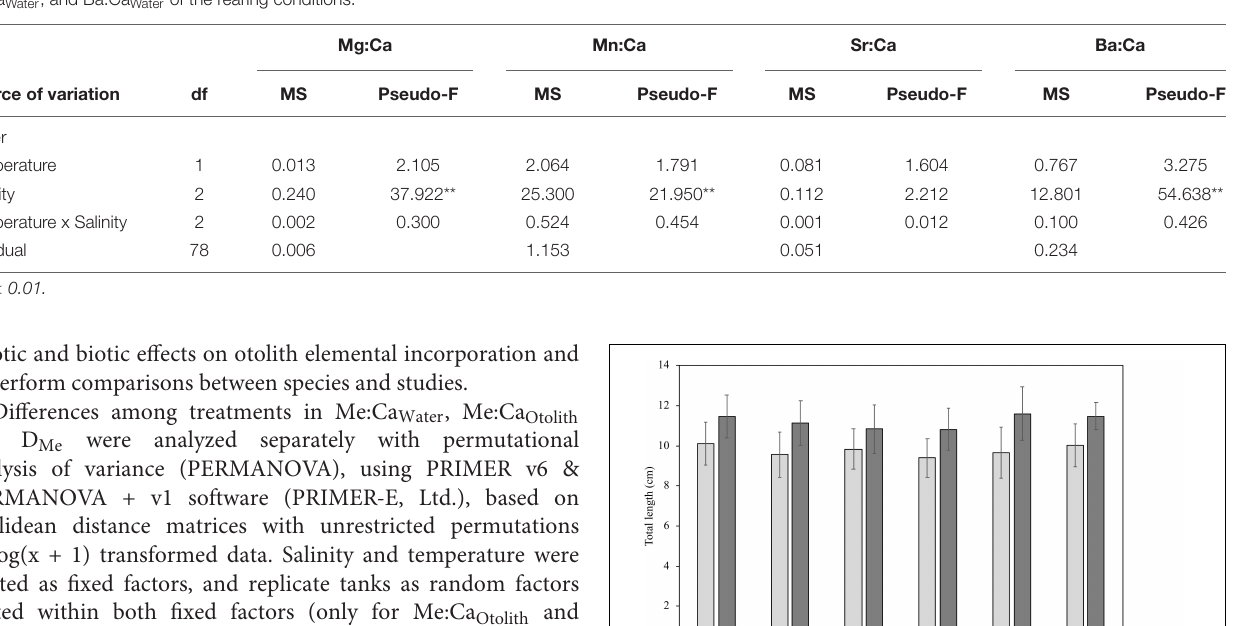
TABLE 2 | Results of the permutational analysis of variance (PERMANOVA) investigating the effects of salinity and temperature on the Mg:Ca Water , Mn:Ca Water , Sr:Ca Water , and Ba:Ca Water of the rearing conditions.